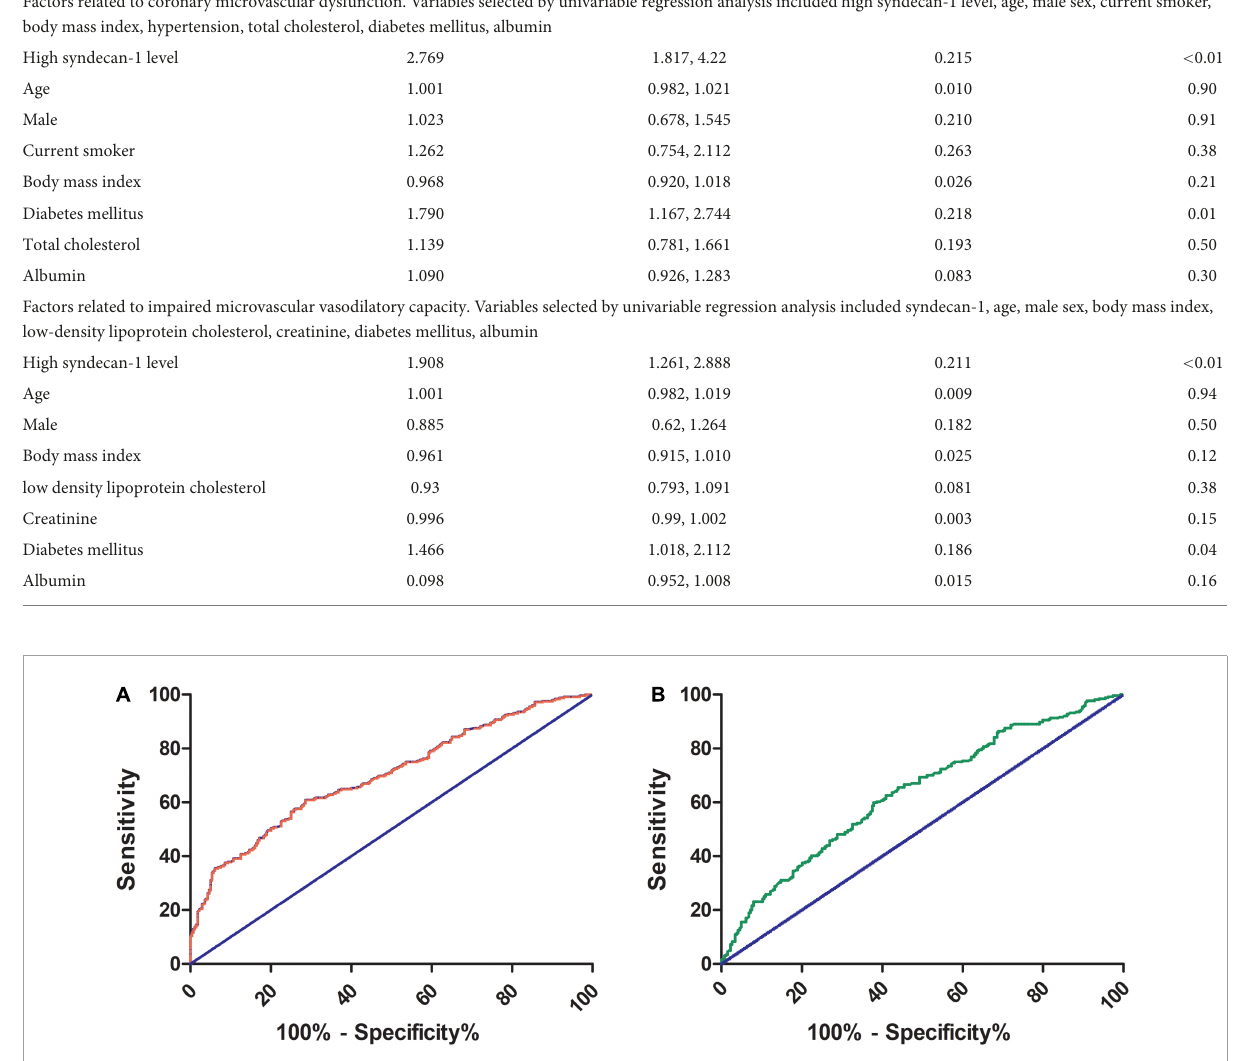
FIGURE3 Receiver operating characteristic (ROC) curve of serum syndecan-1 for the prediction of CMD and IMVC. The areas under the ROC curve for CMD (A) and IMVC (B) were 0.7 (95% CI: 0.65–0.74, P < 0.01) and 0.64 (95% CI: 0.59–0.68, P < 0.01), respectively. For the prediction of CMD and IMVC, the cutoff values of syndecan-1 were 46.99 ng/ml (sensitivity 60.89% and specificity 71.43%) and 54.11 ng/ml (sensitivity 59.85% and specificity 62.12%), respectively. CMD, coronary microvascular dysfunction; IMVC, impaired microvascular vasodilatory